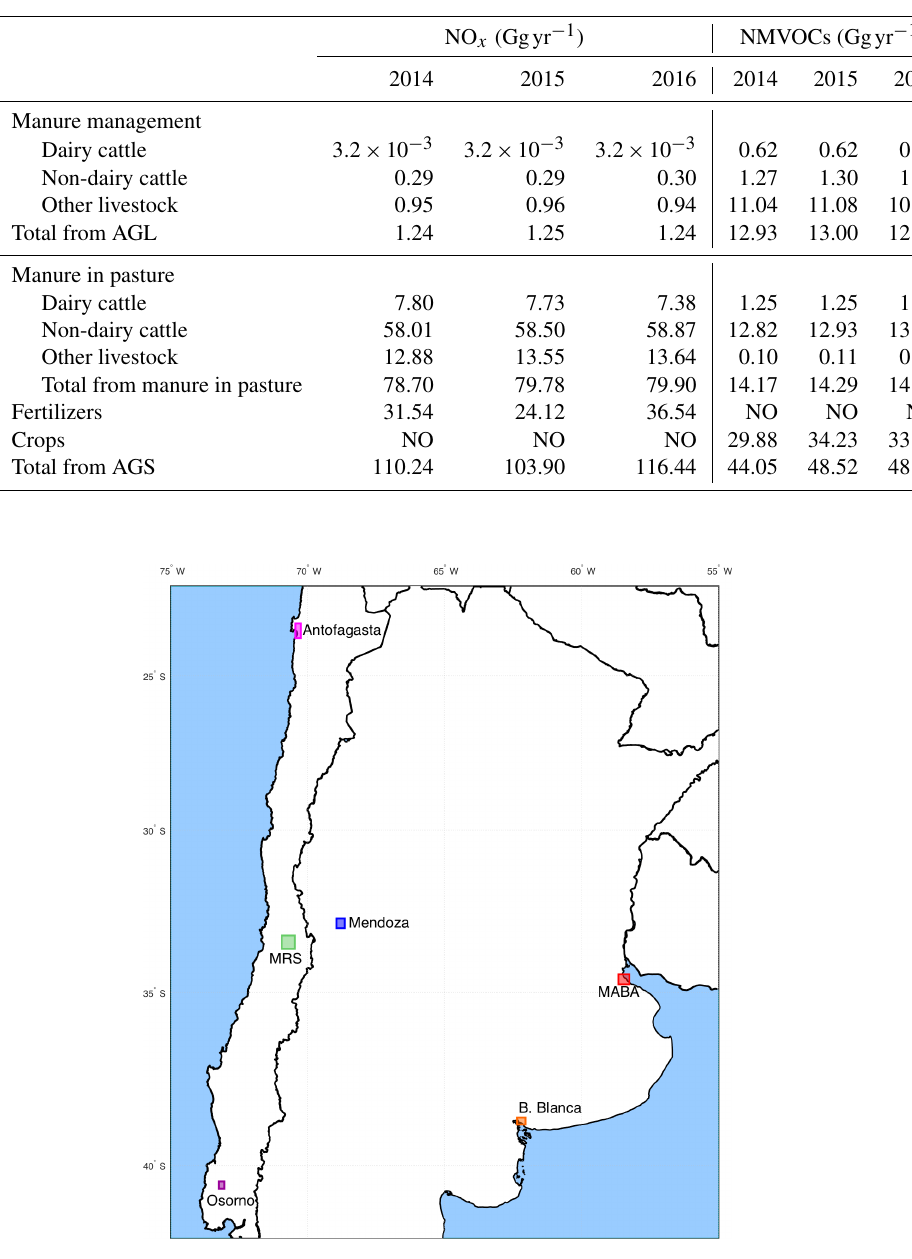
Figure A1. Location of the small domains analyzed.